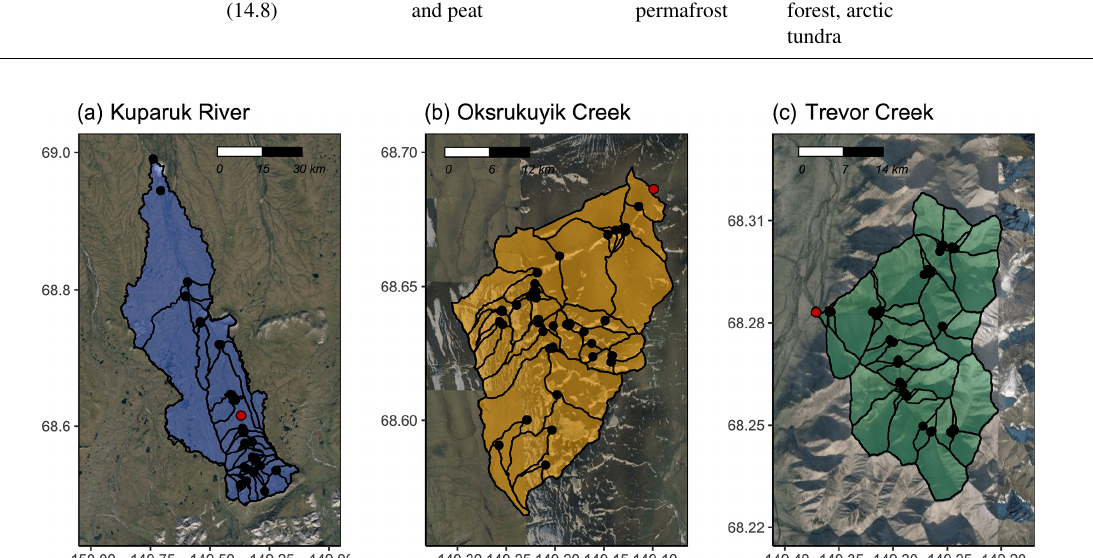
Figure 2. Synoptic sampling sites (black points) with subcatchment delineations from three watersheds related to the Arctic Long-Term Ecological Research site at Toolik Field Station (TFS) on the North Slope of Alaska. Study watersheds include the (a) Kuparuk River (blue), (b) Oksrukuyik Creek (orange), and (c) Trevor Creek (green). Scale bars in kilometers. The Arctic LTER monitoring stations are denoted by red points and described further in Shogren et al. (2021). Map created in R Studio (version 1.2.1335) with base imagery from ESRI and © Google Earth (version